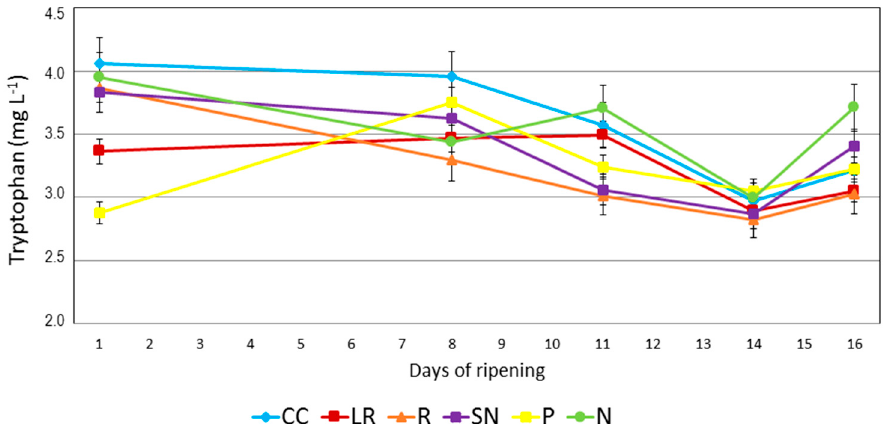
Figure 2. Evolution of tryptophan levels during the ripening period for grapes from five different cultural practices and the reference.